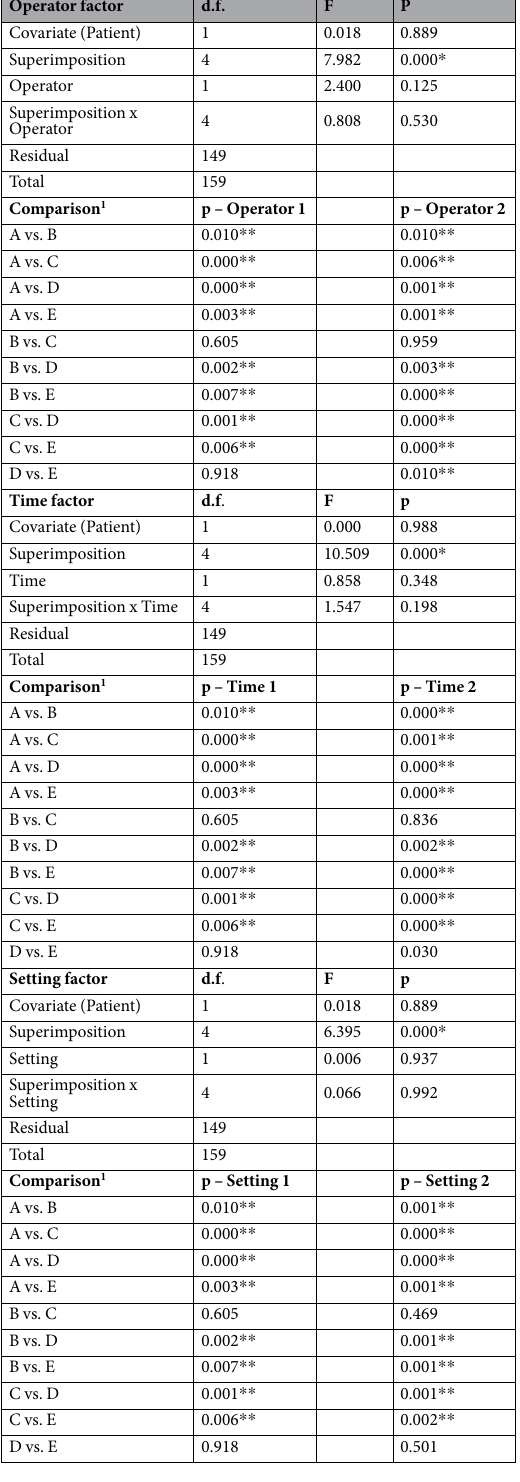
Table 1. Non parametric MANCOVA on accuracy measurements (deviation between structures) by different operators, time points, and settings. Two crossed factors and their interactions were analyzed in each case having “patient” as a covariate: superimposition technique (fixed factor; 5 techniques) and operator (fixed factor; 2 operators) or time (fixed factor; 2 time points) or setting (fixed factor; 2 settings). * p < 0.05. 1 Pair- wise a posteriori tests between superimposition techniques using the Wilcoxon signed-rank test . ** p < 0.01; Bonferroni correction applied. A, B, C, D, E correspond to the five superimposition techniques and reference areas tested in the